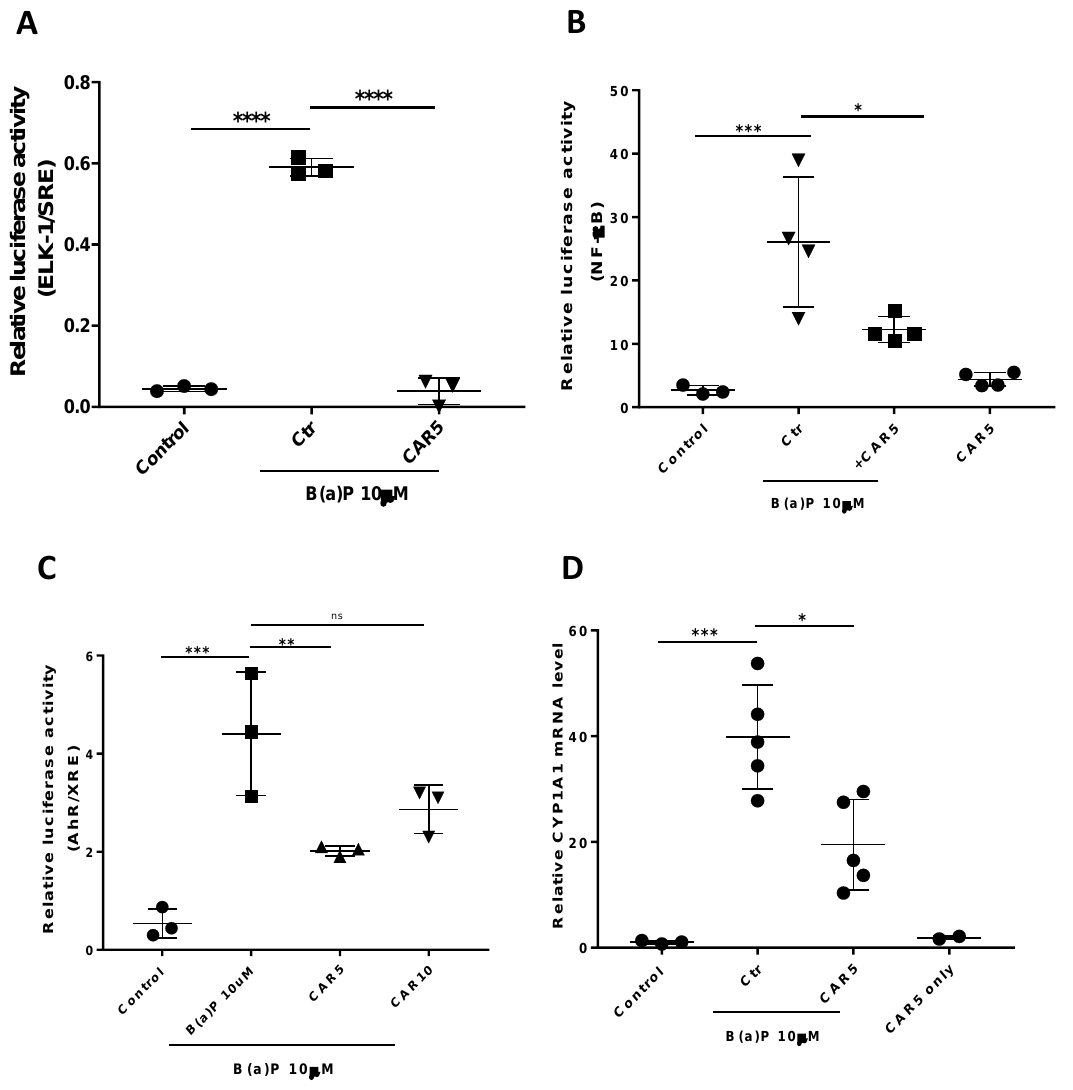
Figure 2. Effects of carvedilol on B(a)P-induced activation of ELK/SRE, NF- κ B and AhR/XRE and expression of CYP1A1 mRNA. ( A ) Effects of carvedilol on B(a)-induced activation of ELK-1/SRE promoter. The BEAS-2B cells expressing exogenously transfected ELK-1/SRE luciferase reporter and the Renilla control reporter (10:1) were treated with vehicle, 10 µM B(a)P, with or without carvedilol for 24 hours before dual luciferase assay. ( B ) Effect of carvedilol on B(a)P-induced NF- B promoter activity. The BEAS - 2B cells expressing exogenously transfected NF- B luciferase reporter and Re- nilla control reporter (10:1) were treated with vehicle, 10 µM B(a)P, with or without carvedilol for 24 hours before dual luciferase assay. ( C ) Effects of carvedilol on B(a)P-induced AhR/XRE promoter activity. The BEAS-2B cells expressing exogenously transfected AhR/XRE luciferase reporter and Renilla control reporter (10:1) were treated with vehicle, 10 µM B(a)P, with or without carvedilol for 24 hours before dual luciferase assay. ( D ) Effect of carvedilol on B(a)P-induced mRNA expression of CYP1A1 determined using qRT-PCR. The BEAS-2B cells were treated with B(a)P (10 µM), with